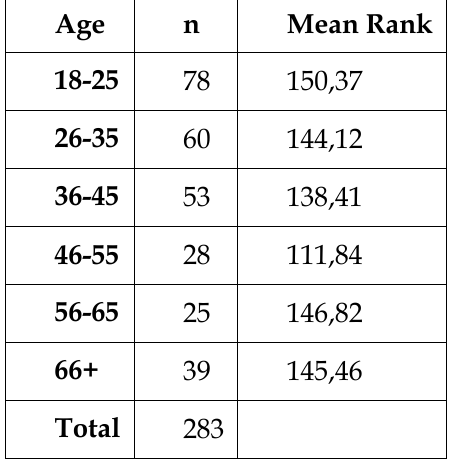
Figure 1. Concern about breaching personal privacy and age. Percentage per reported value on scale. 5-1 18- 25 years n=78 (100%), 26-35 years n=60 (100%), 36-45 years n=53 (100%); 46-55 years n=28 (100%); 56- 65 years n=25 (100%); 66+ years n=38 (100%). Total n=282. Figure 1 indicates minor differences by age in the three younger age categories. Age category ‘46- 55 years’ report the lowest concern. We also see that 5 and 1 are more frequently reported than 4-2. The majority of the respondents belong to the three younger age categories. Table 4. Concern about breaching personal privacy and age. Kruskal-Wallis mean